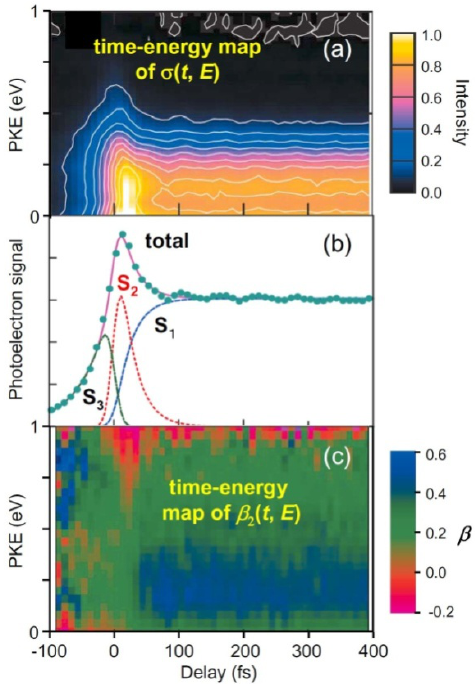
Figure 5. ( a ) Time-evolution of PKED, σ ( t , E ); ( b ) Temporal profiles of total photoelectron signals in (1+1 ' ) TRPEI of pyrazine-h4. The observed data are well explained by three components: single-exponential decay of S (red), corresponding increase in S (blue) 2 1 at a positive time delay, and single-exponential decay of S (green) at a negative time delay. 3 The fitting result is shown by the solid line; ( c ) Time-evolution of photoelectron angular anisotropy parameter β ( t , E 2